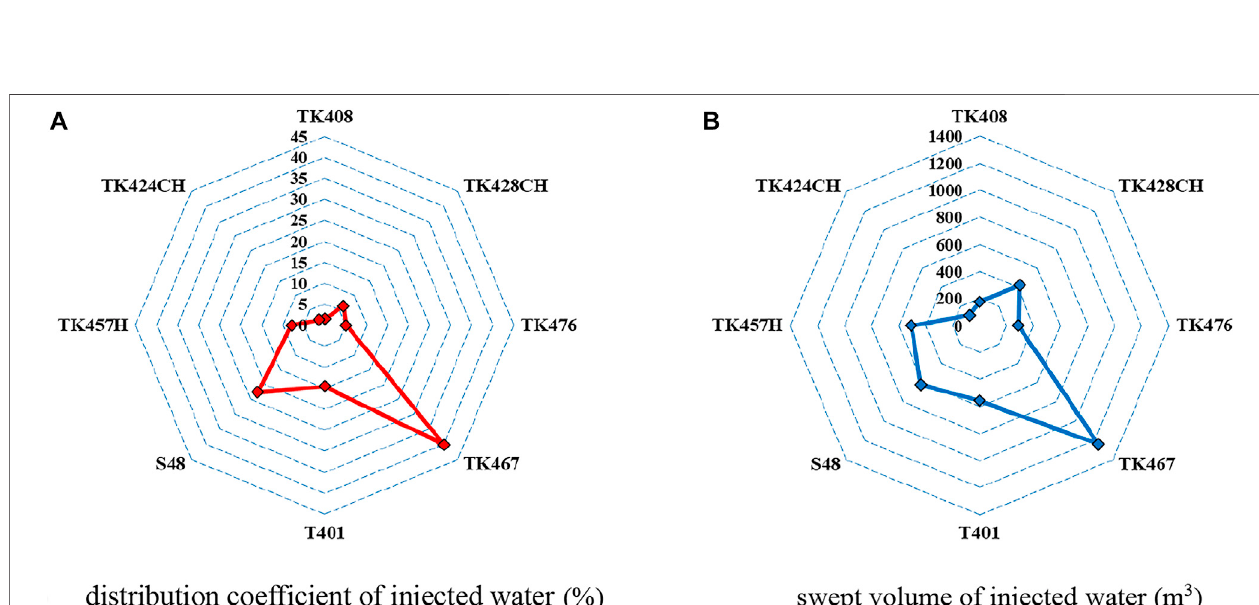
Frontiers in Energy Research |